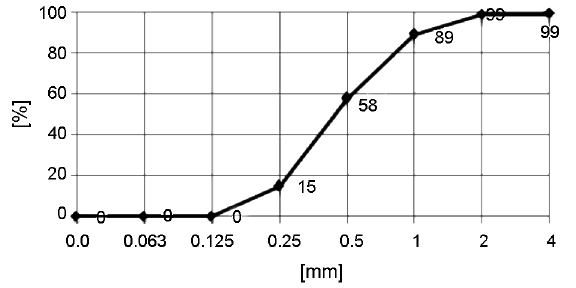
Fig. 1. The grain size distribution of sand